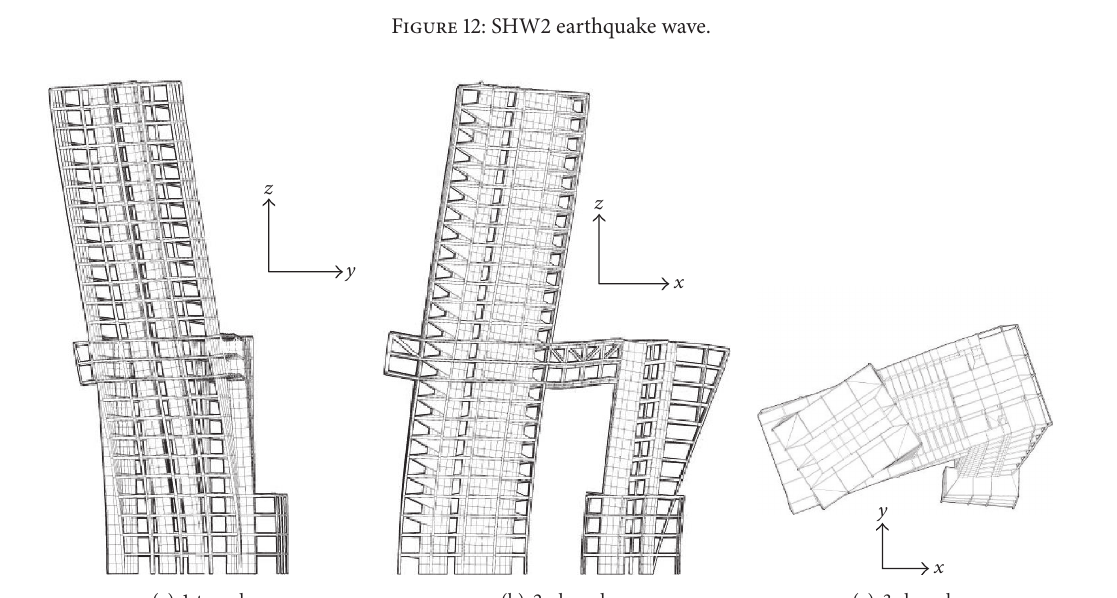
Figure 12: SHW2 earthquake wave.